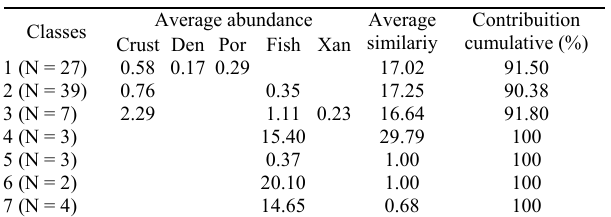
Table 2. SIMPER analysis of similarity between classes of length of the Lutjanus analis , captured in the Abrolhos Bank coral reefs, Eastern Brazil, between June 2005 and March 2007. (Crust, Den, Por, Xan, corresponds respectively to Crustacea remains, Dendrobranchiata, Portunidae, and